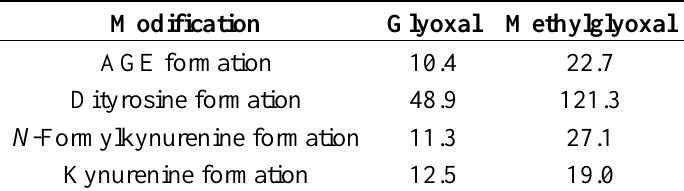
Table 1. Apparent second-order rate constants for the reactions of